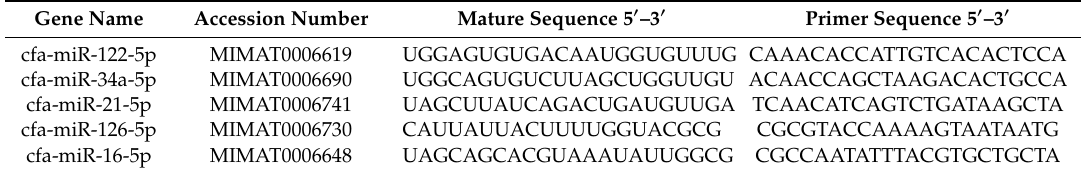
Table 2. Mature sequences and specific forward primers for endogenous reference and target